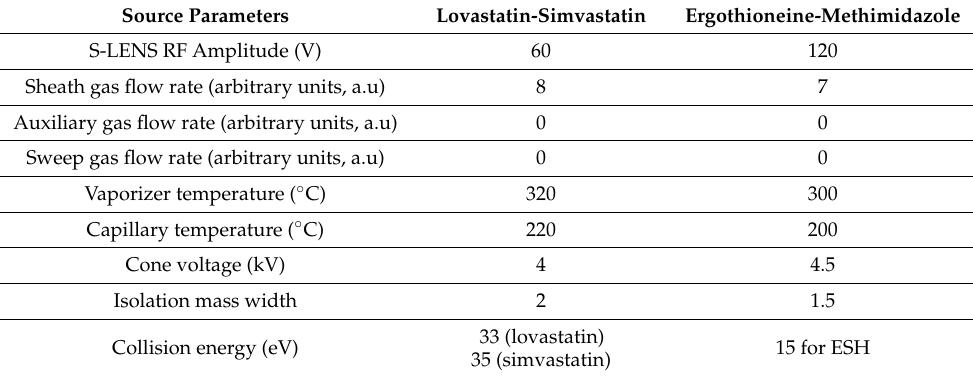
Table 5. Optimized values of electrospray chemical ionization (ESI) parameters for the examined